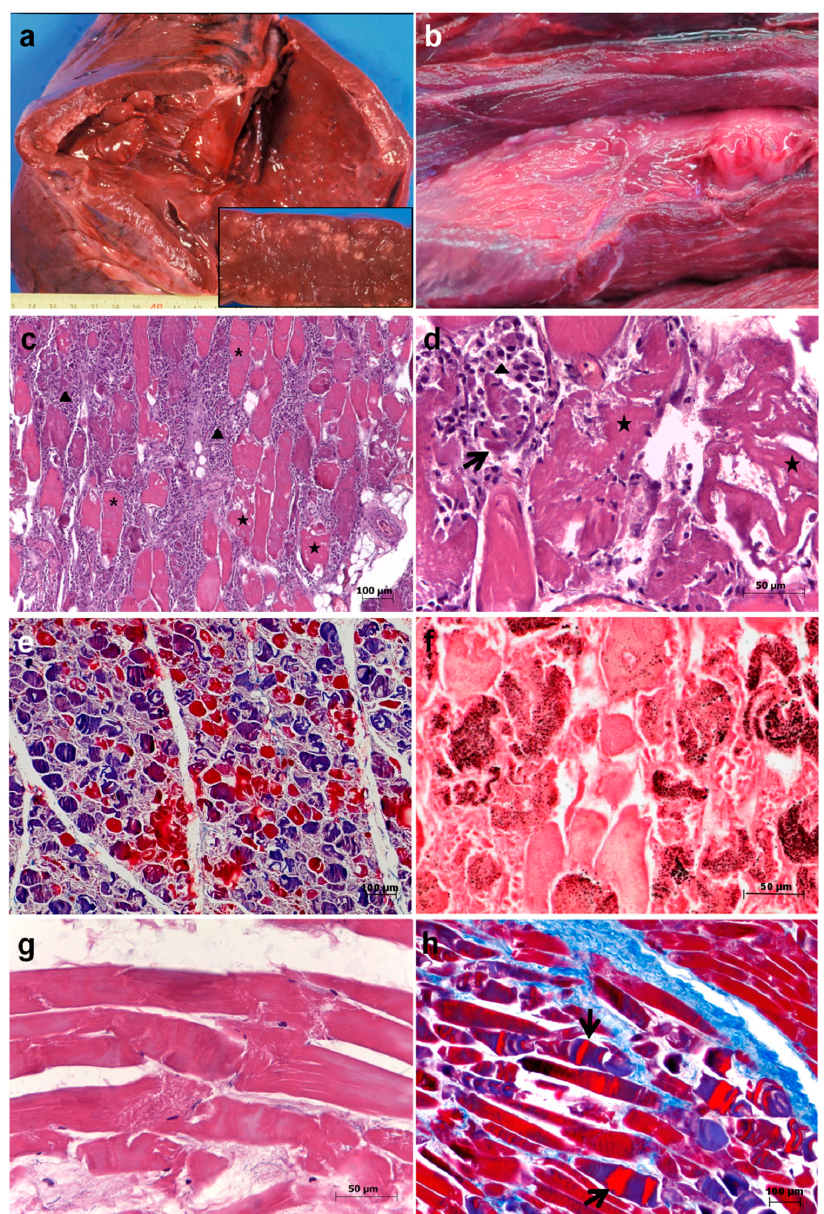
Figure 2. Severe exertional myopathy in Eurasian brown bears. ( a , c , d , e , f ) Bear 1; ( b , g , h ) Bear 9 (see Table 1 for details). ( a ) Gross lesions consisted of dry and pale cardiac muscle. Inset: detail of lesions in myocardium; ( b ) gross lesions consisted of pale skeletal (femoral) muscle; ( c ) extensive segmental hyaline degeneration in femoral muscle, hypercontracted fibers (asterisks), coagulative necrosis and